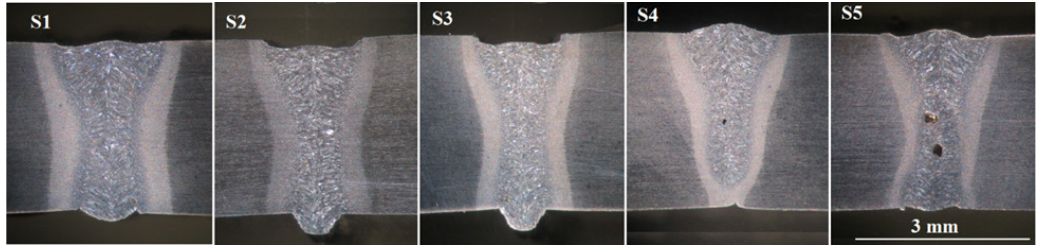
Figure 3. Cross-sections macrographs of the welded series.